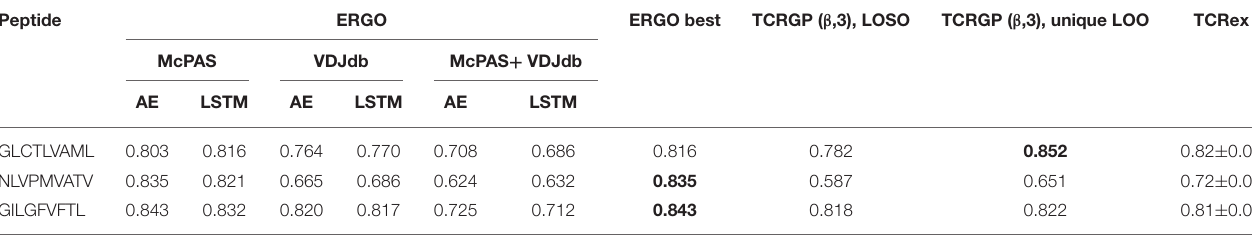
TABLE 2 | Comparison between the different versions of the ERGO classifier [AE vs. LSTM and McPAS (23) vs. VDJdb (27)] and existing classifiers [TCRGP by Jokinen et al. (19), TCRex by Gielis et al. (20)] for the SPB task. Peptide ERGO ERGO best TCRGP ( β ,3), LOSO McPAS VDJdb McPAS + VDJdb LSTM AE LSTM AE LSTM